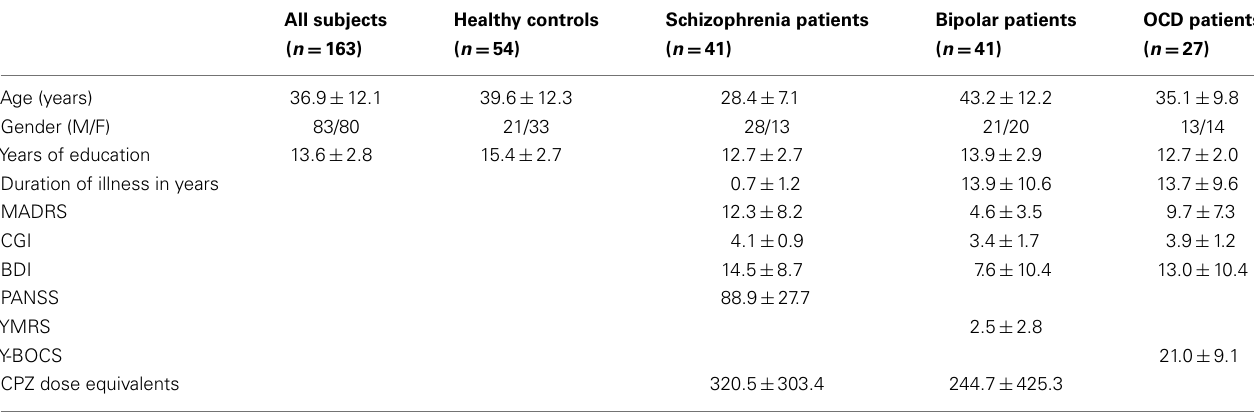
Table 1 | Demographic and clinical data of study subjects .